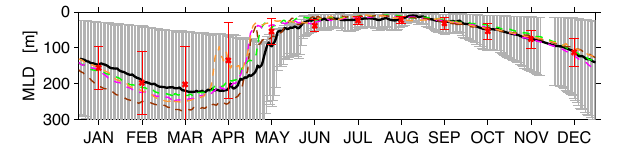
Fig. 5. Surface mixed layer depth (defined as the depth where den- sity σ 0 exceeds surface values by 0.125) averaged over the region bounded by 143 ◦ E to 160 ◦ E and 33 ◦ N to 42 ◦ N. The red crosses are calculated from a total of 1796 Argo profiles in the period 1998 to 2004. The vertical red lines are associated standard devia- tions calculated from all observations found in the region at a given month. The black line is calculated from simulated, daily snapshots of model year 1993. The vertical grey lines denote the associated standard deviation which represents the simulated spatial variabil- ity at a given day. The gap in November is caused by files corrupted during integration. The dashed green, magenta, brown, orange lines correspond to simulated nominal years 1994 to 1997,